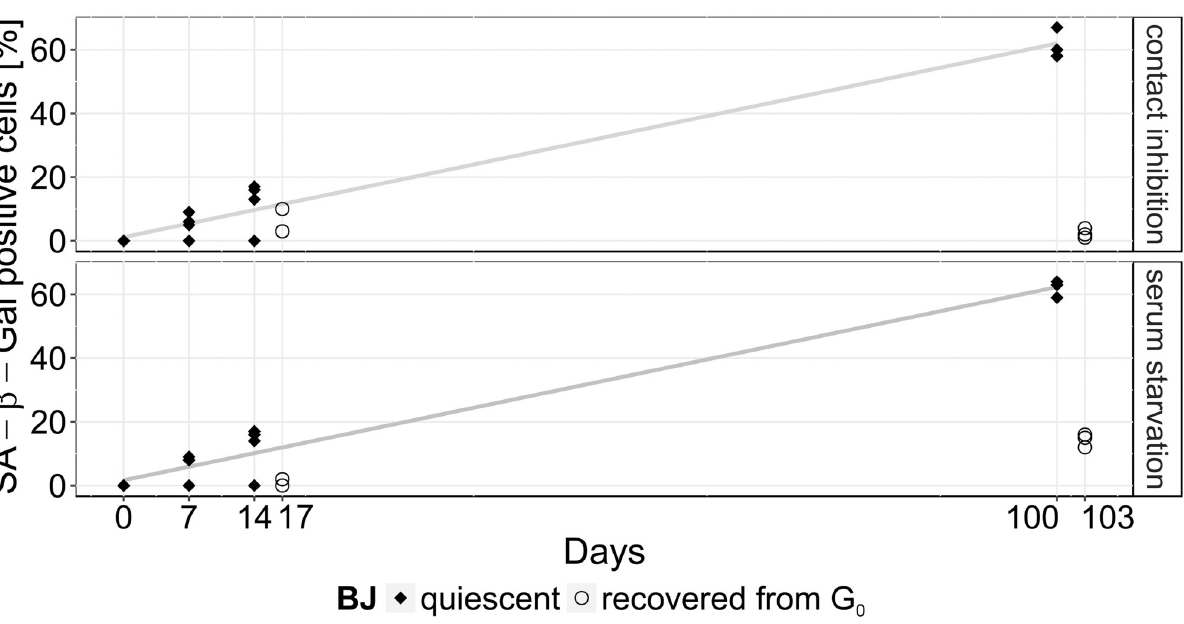
Fig 1. Number of positively SA β -Gal stained quiescent cells. Percentage of positively stained SA β -Gal fibroblasts during short- (0, 7 and 14 days) and long-term (100 days) cultivation of quiescent BJ cells (black dots) transferred by contact inhibition (top) or serum starvation (bottom). After 14 and 100 days, cells were cultivated for 3 days in total under normal proliferating conditions (“recovered from G 0 “; unfilled circles). Each data point represents a single experiment and the experimental error of all measured values is about ± 10%.